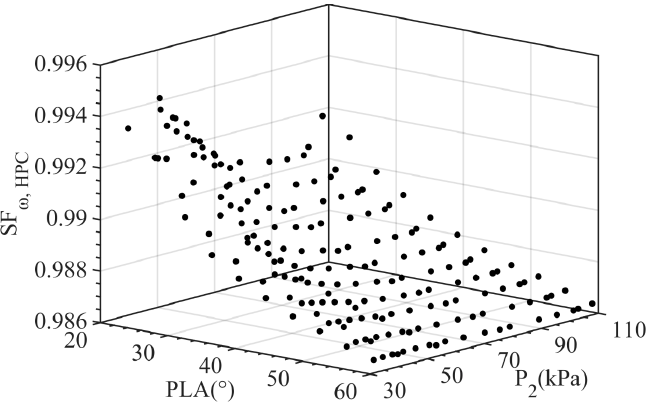
Figure 7. The scatter of the SF ω , HPC